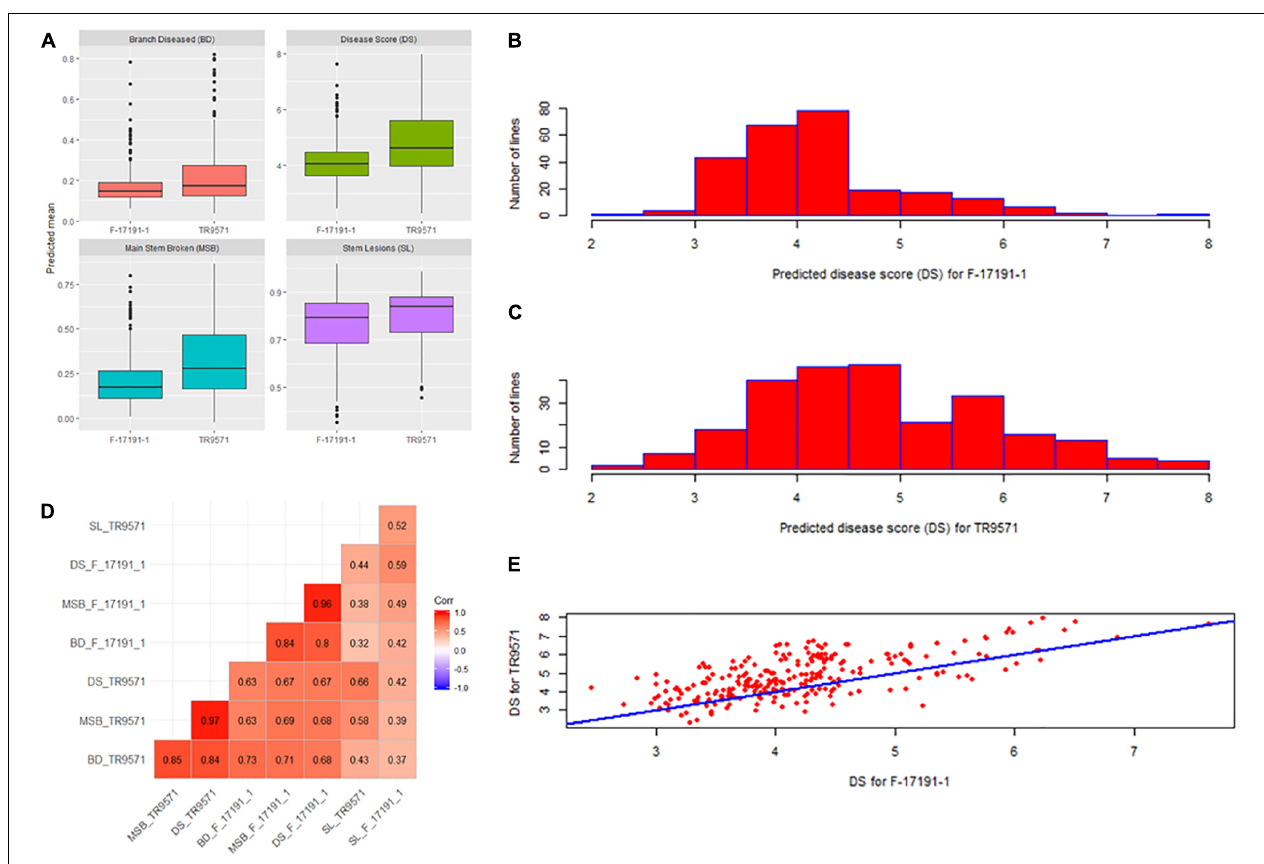
FIGURE 1 | Genetic variation for resistance to Ascochyta blight in a genome-wide association (GWAS) set. (A) Box plot of four disease measures against two Ascochyta rabiei isolates. (B) The frequency distribution of disease scores in the GWAS set against F-17191-1 isolate. (C) The frequency distribution of disease scores in the GWAS set against TR9571 isolate. (D) Pair-wise correlations between different disease measures scored using two isolates. (E) Scatter plot showing relationship between predicted disease scores in the GWAS set after infection with F17191-1 and TR9571